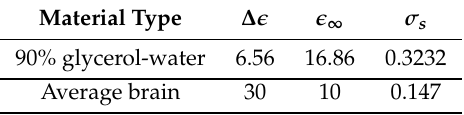
Table 3. Debye parameters of materials after curve fitting to measured dielectric